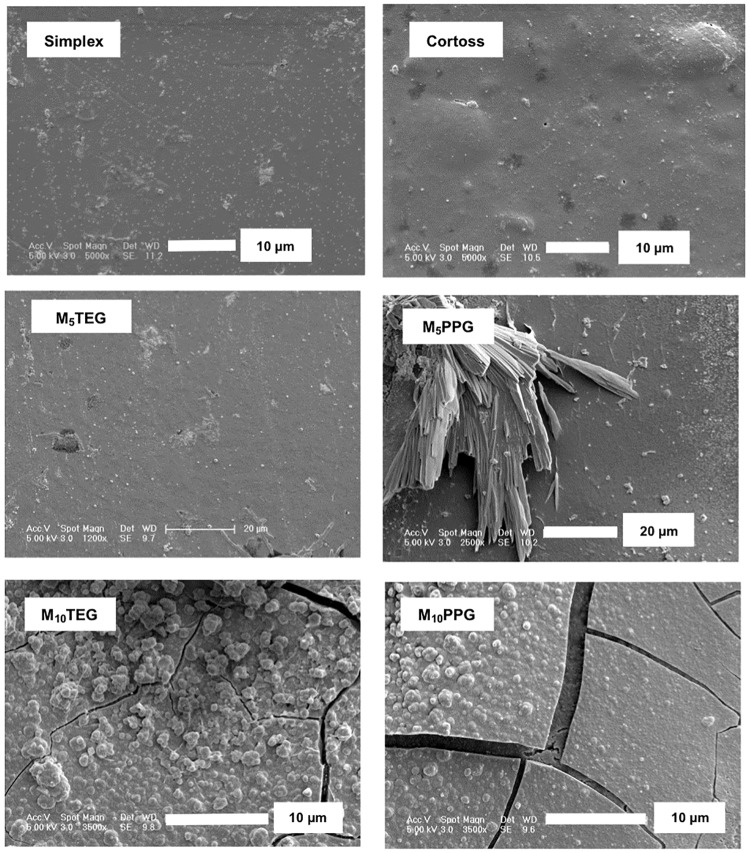
Representative SEM images for each material after immersion in SBF for up to 7 days.